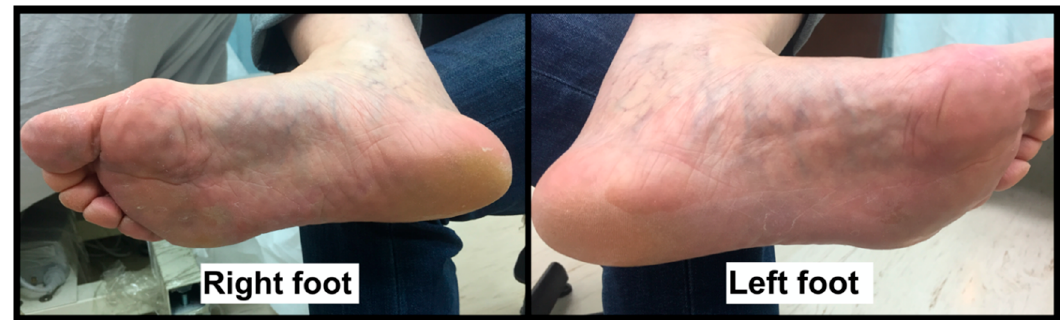
Figure 1. A photograph of the right (symptomatic) and left (asymptomatic) soles of the patient. A mild medial mid-sole bulging can be observed on the right side.